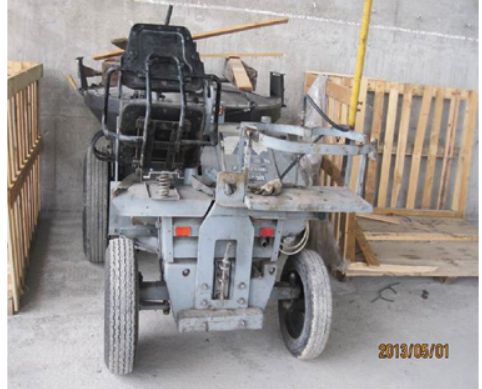
Figure 1. Conventional